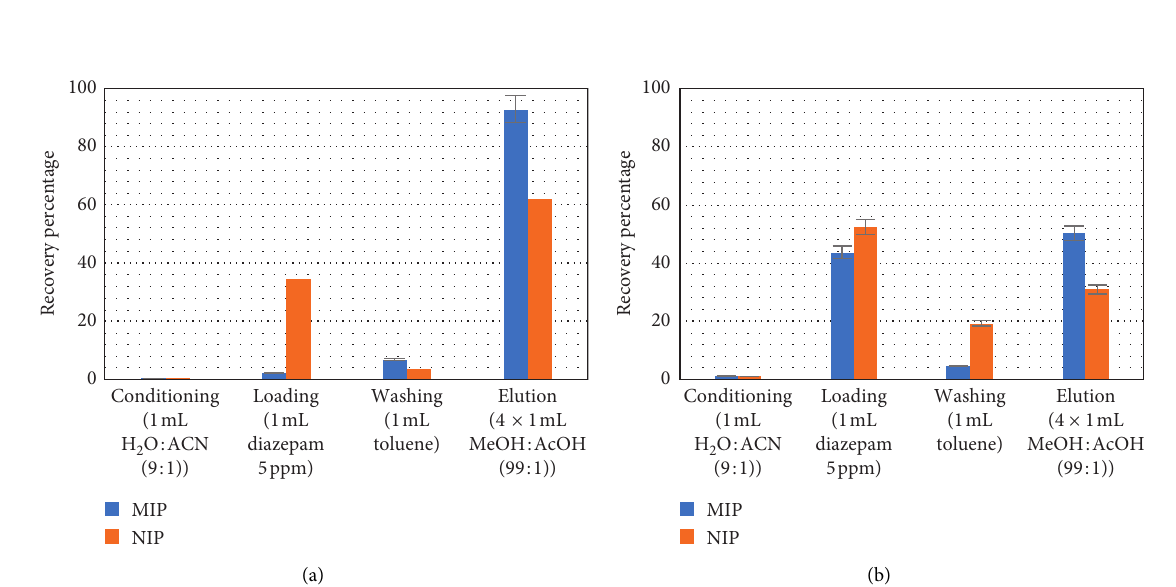
Figure 3: Recovery percentage of MMA polymer (a) and AAM polymer (b) with SPE condition (conditioning: 1mL H loading: diazepam in MeOH, washing: 1mL toluene, eluting: 4 × 1 mL MeOH : AcOH (99 :1)). The error bars represent the standard deviation of three separate runs ( n � 3).